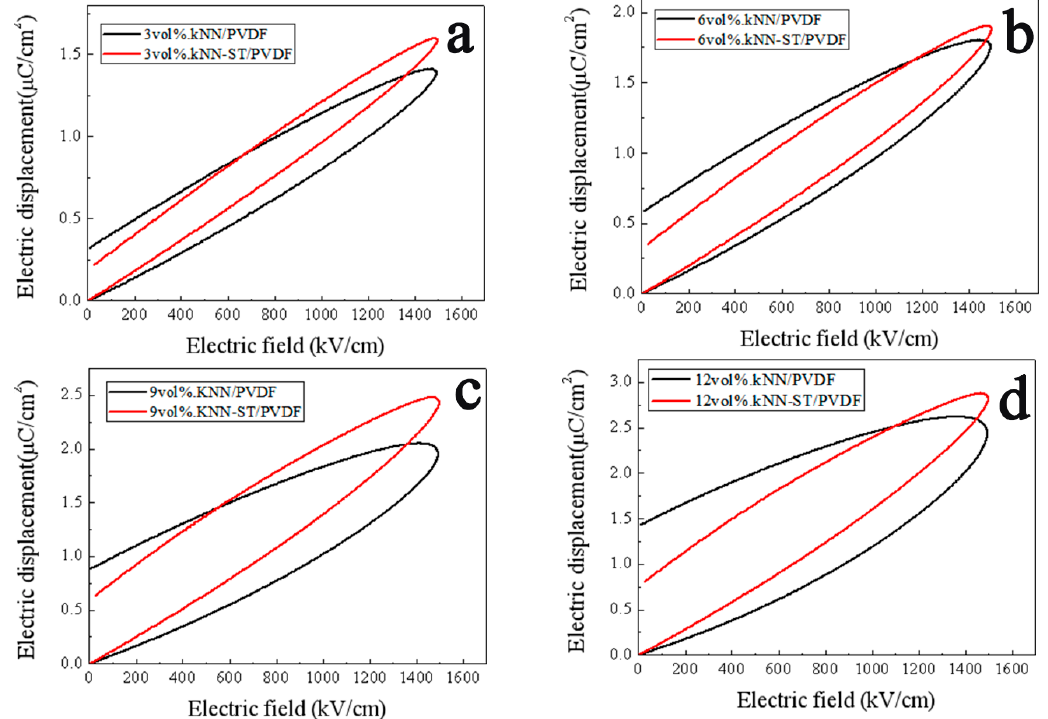
Figure 7. Ferroelectric hysteresis loops of KNN/PVDF and KNN-ST/PVDF composite films.